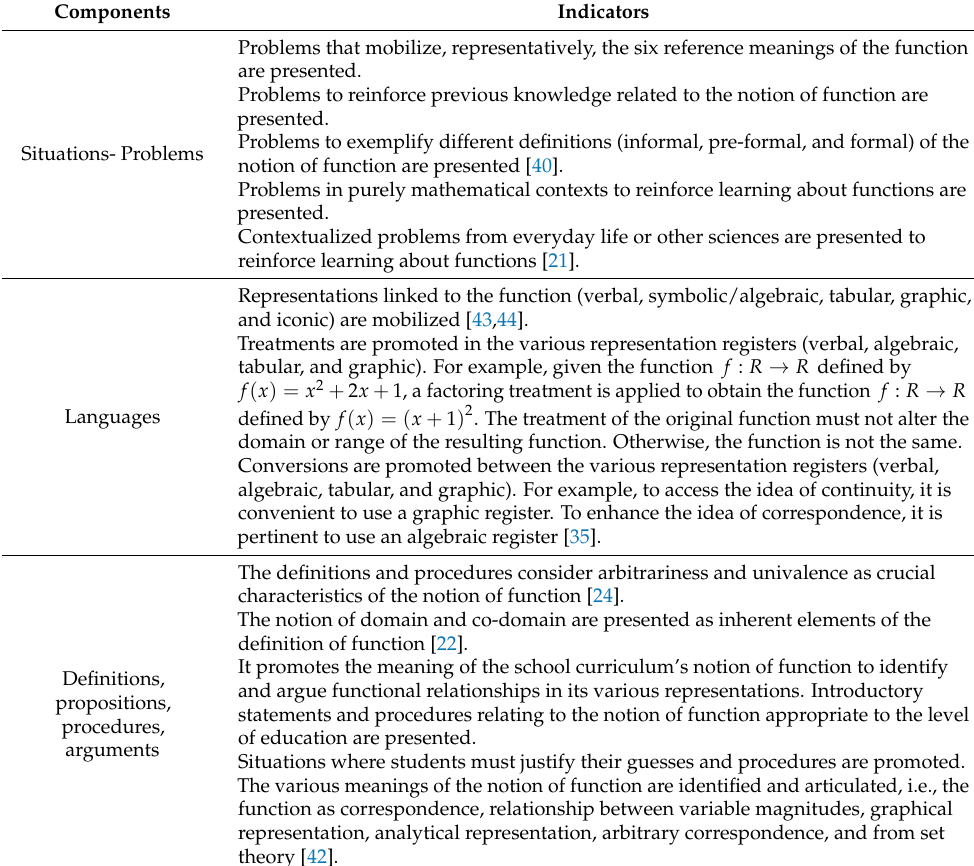
Table 1. Epistemic suitability for teaching